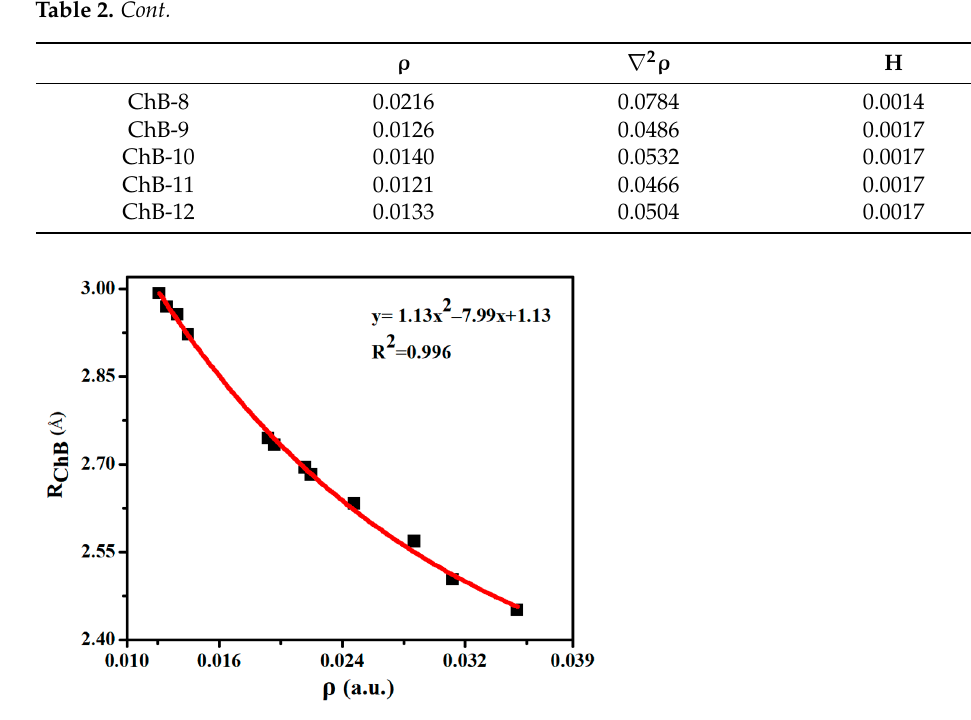
Figure 3. Binding distances (R ChB ) versus electron density ( ρ ) at the Se···O BCP in the chalcogen- bonded dyads.